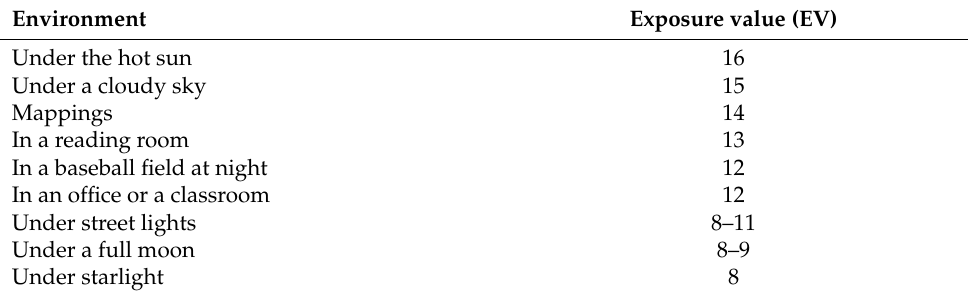
Table 2. Illuminance in different environments [19].